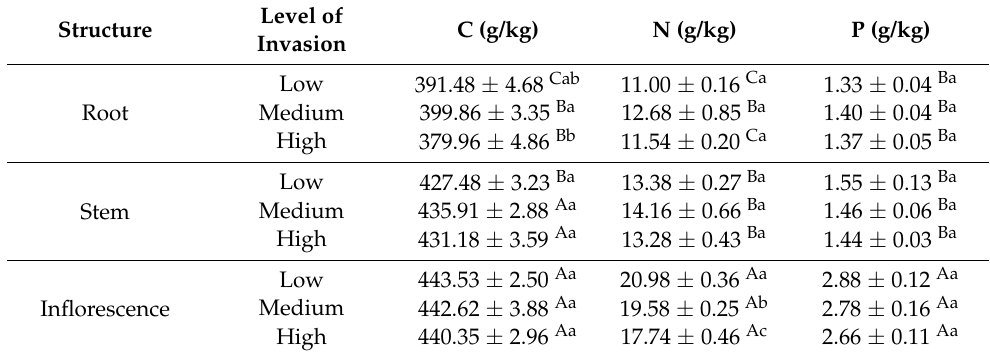
Table 5. C, N, and P content of structures of Pedicularis kansuensis with different invasion levels.